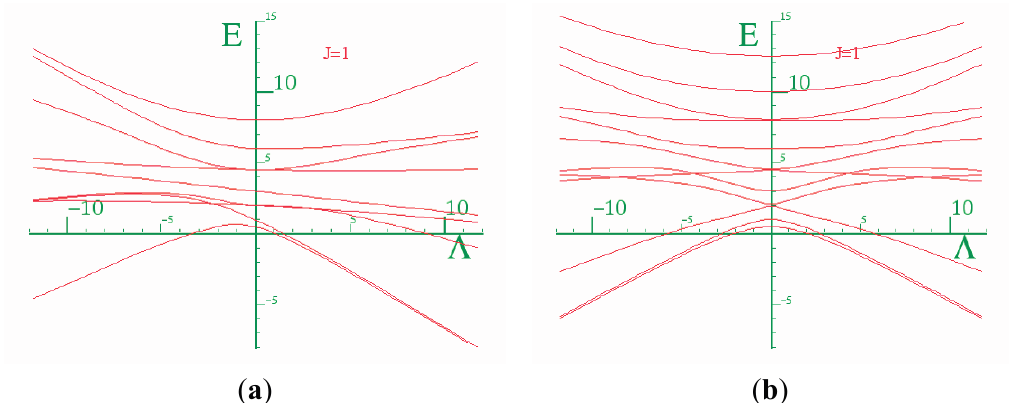
Figure 3. Energy vs. coupling of X 2 for J = 1. ( a ) n = 2; ( b ) n = 3.